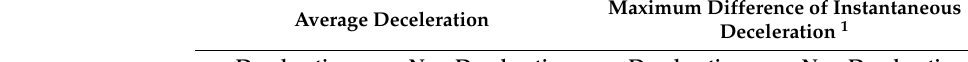
Table 2. Test results of Figure